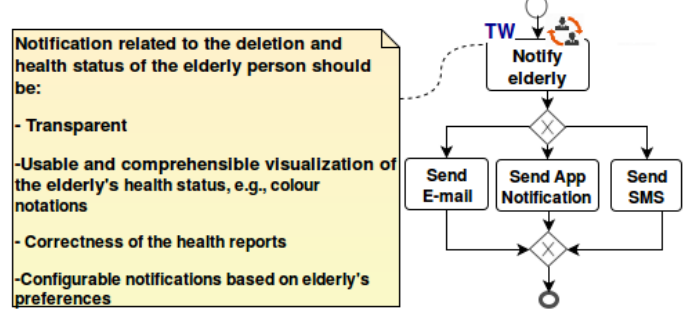
Figure 11. Exemplary further refinement on the business process model (within the solution peak).